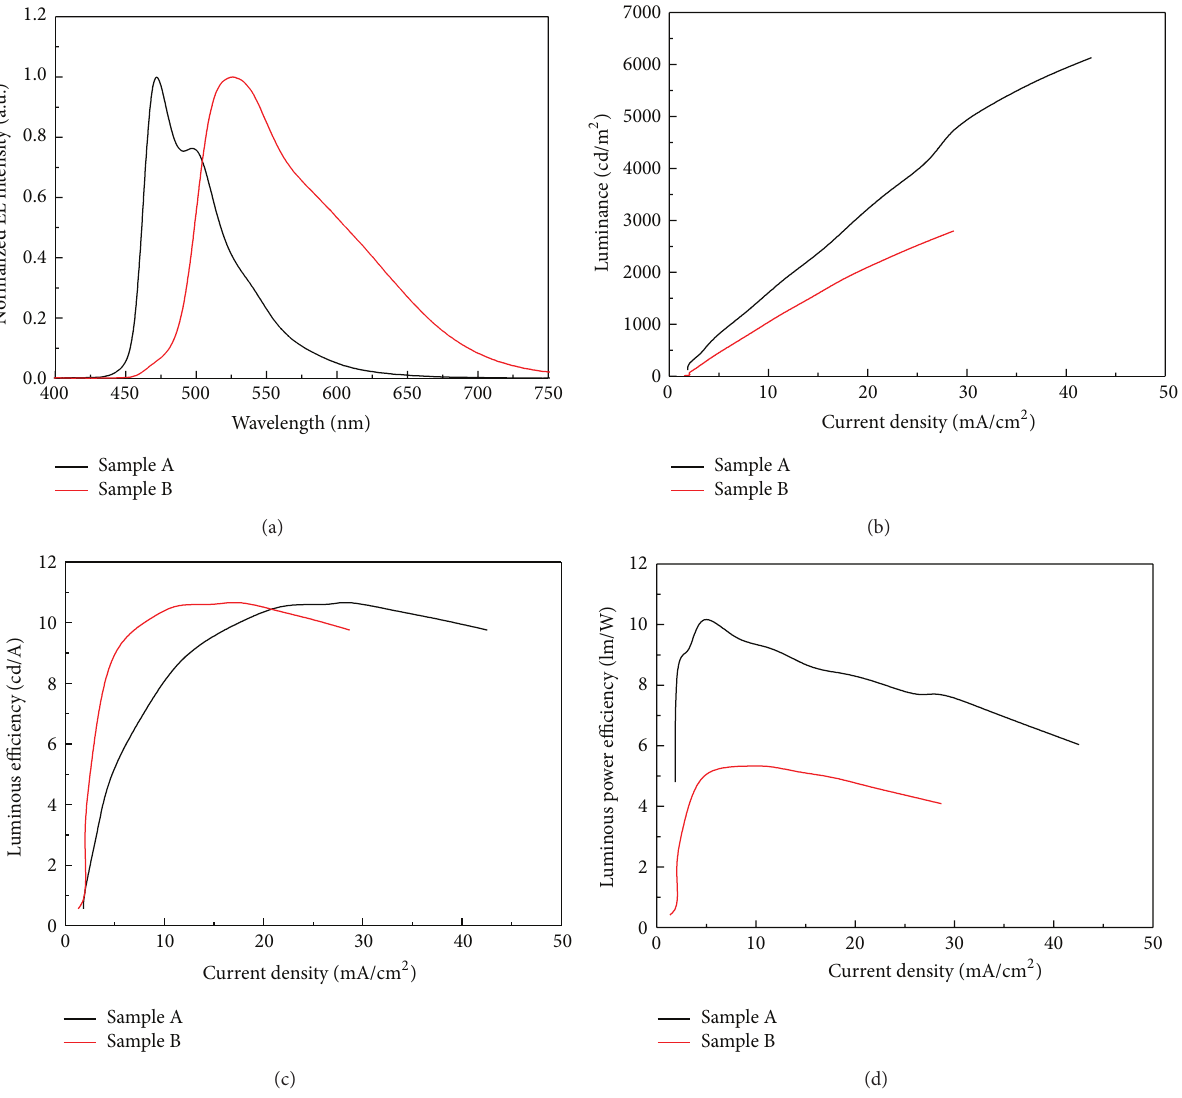
Figure 3: (a) The measured EL spectra in the normal direction of Sample A and Sample B. (b) Luminance, (c) current efficiency, and (d) luminous power efficiency characteristics of Sample A and Sample B as a function of current